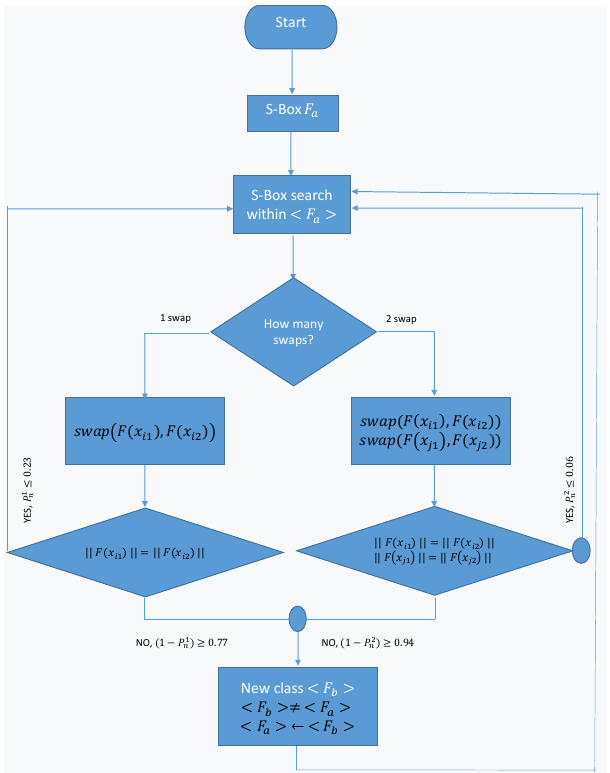
Figure 11. Influence of the random swap operator (for 1 or 2 swaps) on the exploration–exploitation balance during the search for S-boxes resistant to Power Attacks in the Hamming Weight class